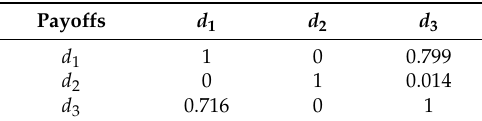
Table 6. Payoff table of r =